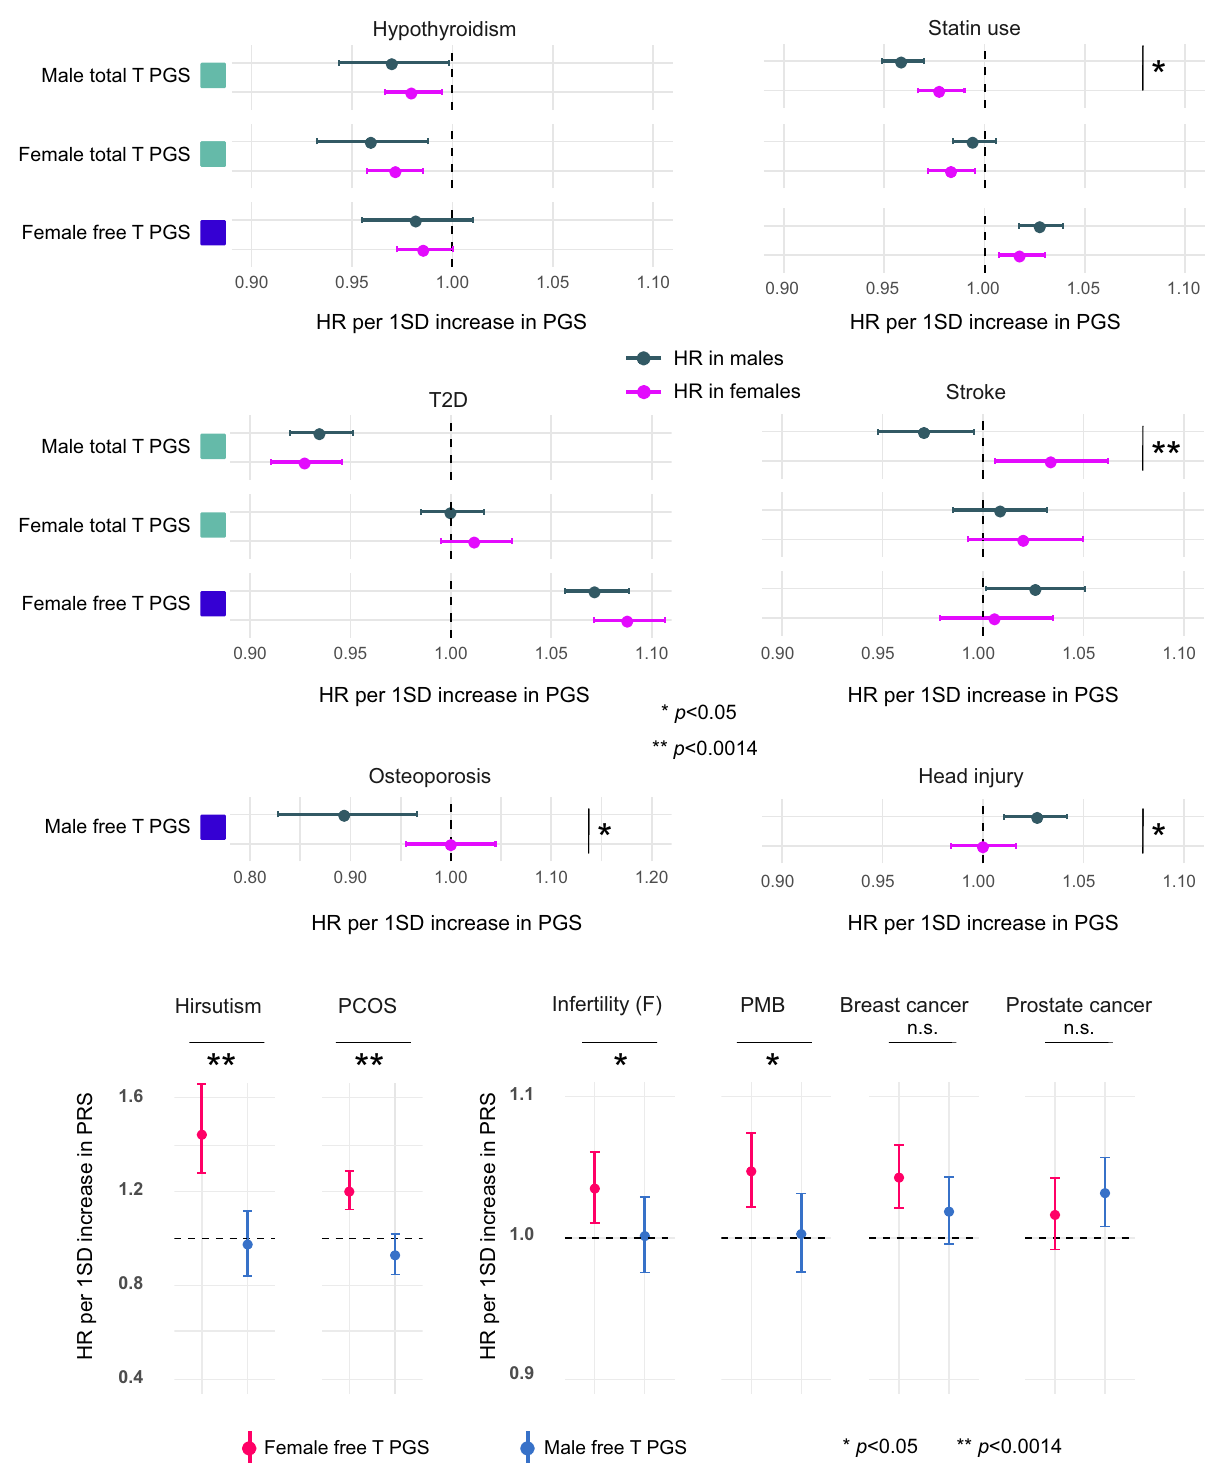
Fig. 4 Results from the cross-sex PGS analyses. a , b Show HR point estimates with 95% con fi dence intervals. a Cross-sex PGS associations with hypothyroidism, statin use, T2D and stroke. p < 0.05 suggests that the effects of a given PGS vary depending on sex. Green = total T PGS, blue = free T PGS. Dark green = HR in males, pink = HR in females. b Illustration of cases with statistical evidence for male and female PGSs having different effects (hirsutism, polycystic ovary syndrome (PCOS), infertility and post-menopausal bleeding (PMB). No evidence for such difference for breast and prostate cancers. Red estimates = female free T PGS, blue = male free T PGS. The data are based on 94,478 men and 122,986 women from FinnGen R5. Case and control numbers for each endpoint are available from Supplementary Data 9. *Chi-Squared p < 0.05, **Chi-Squared p < 0.0014, n.s. = not signi fi